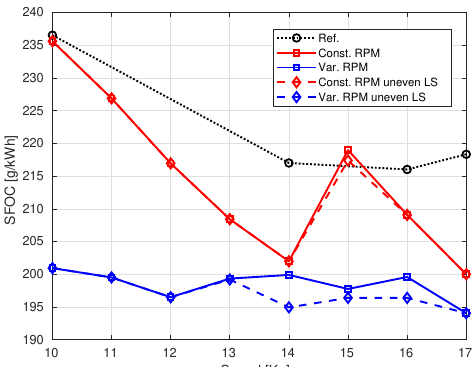
Figure 8. Constant vs. variable revolution speed performance comparison: SFOC with even and uneven load